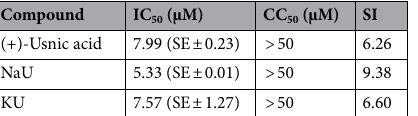
Table 4. Anti-SARS-CoV-2 efficacy of (+)-usnic acid and its salts (NaU and KU).